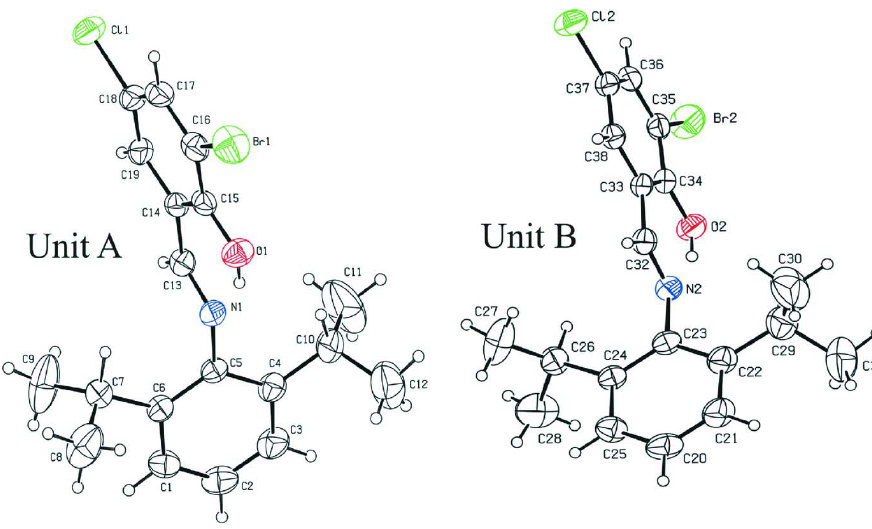
Figure 1 The molecular structure of title compound showing 30% probability displacement ellipsoids.